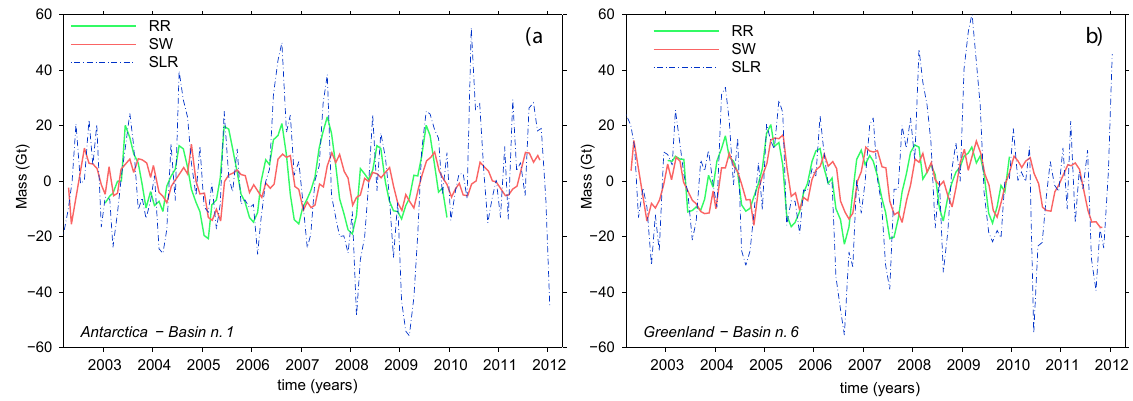
Fig. 6. Three time series detrended correction in Gt for degree-1, for basin 1 for Antarctica (a) and basin 6 for Greenland (b) . The green line (RR) uses the Rietbroek et al. (2012a), the red line (SW) uses the Swenson et al. (2008) and the blue dotted line uses the SLR – Cheng et al. (2010) geocenter contribution to the selected